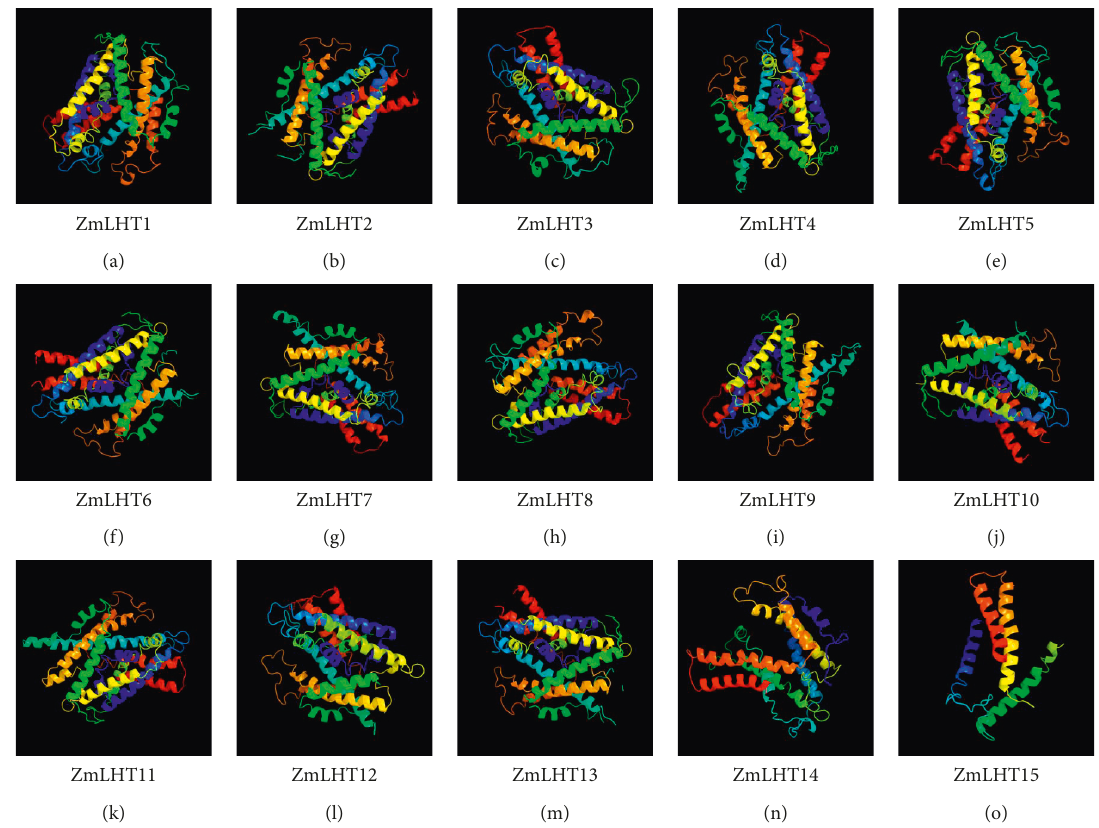
Figure 4: Analysis of three-dimensional protein structure of LHT gene family in maize.